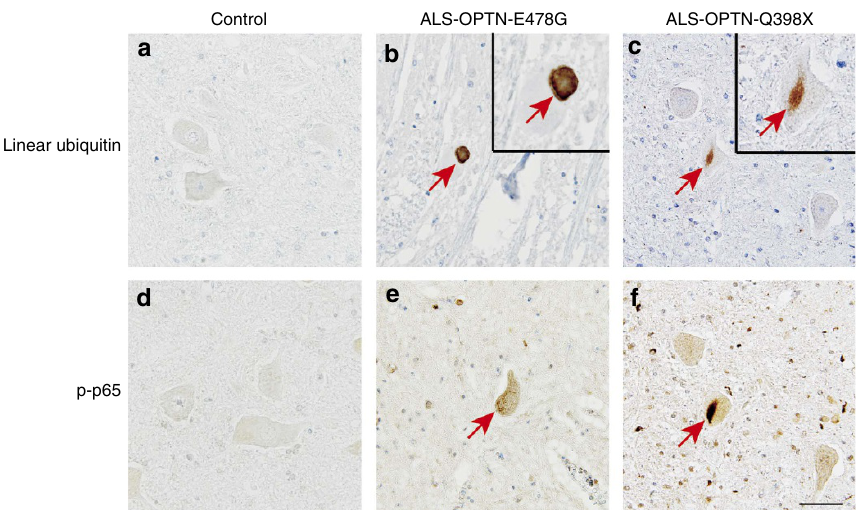
Figure 6 | Intracytoplasmic inclusions of OPTN-associated ALS are immunoreactive to linear ubiquitin. Immunohistochemical staining of specimens from a leukaemia patient (control) and ALS patients with the heterozygous OPTN-E478G mutation and the homozygous OPTN-Q398X mutation was performed using anti-linear ubiquitin ( a – c ) and anti-P-p65 ( d – f ). Arrows indicate immunoreactive inclusions ( b , c , e , f ) in the spinal anterior horn cells. Scale bar, 50 m m.